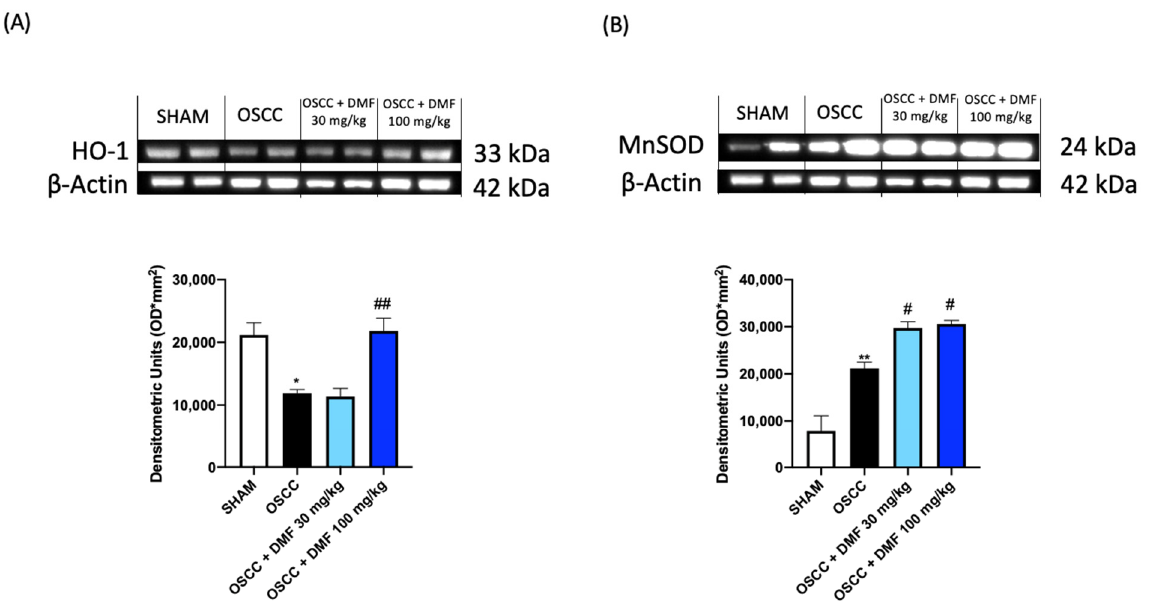
Figure 9. Effect of DMF on HO-1 and MnSOD expression in tongue samples ( A , B ). The blots revealed a significant increase of antioxidant expression of HO-1 after DMF treatment especially at the dose of 100 mg/kg and MnSOD at both doses. ( A ) * p < 0.05 vs. SHAM; ## p < 0.01 vs. OSCC; ( B ) ** p < 0.01 vs. SHAM; # p < 0.05 vs.